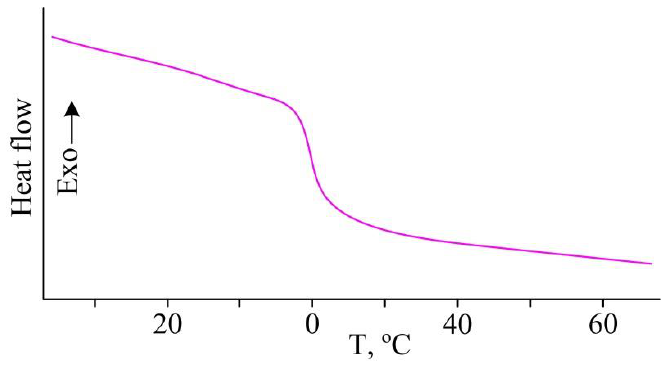
Figure 4. DSC curve of the extractant.